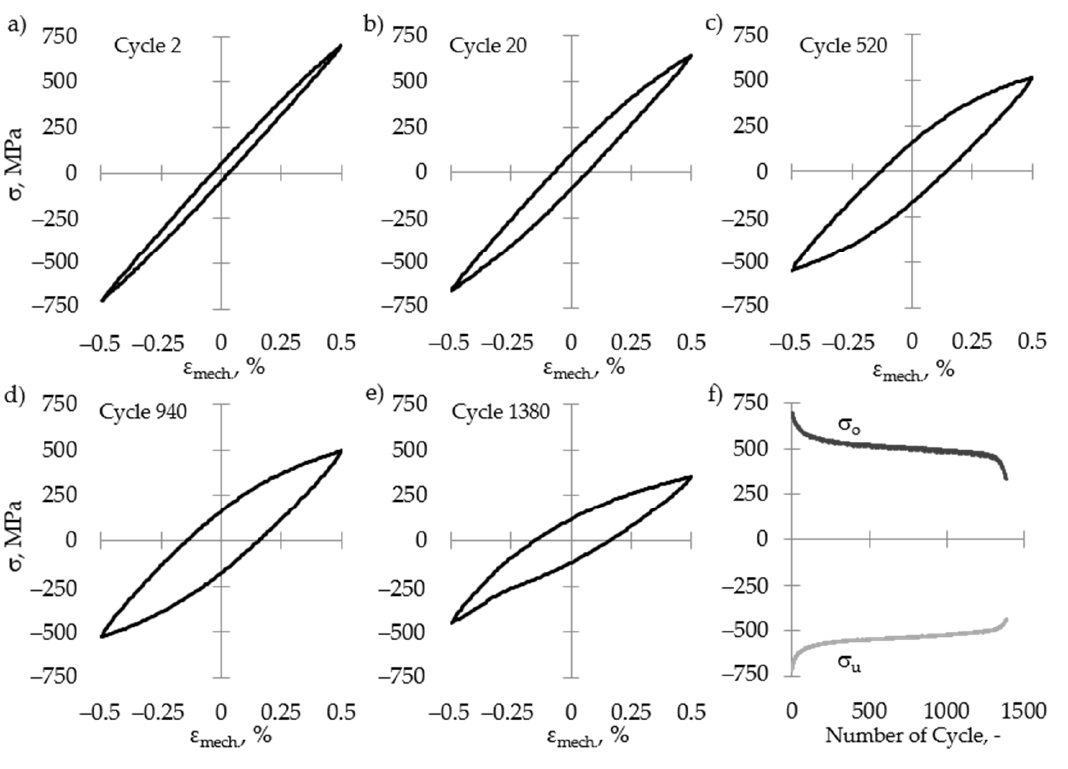
Figure 5. Stress−strain hysteresis loops after ( a ) 2 cycles, ( b ) 20 cycles, ( c ) 520 cycles, ( d ) 940 cycles, ( e ) 1380 cycles, and ( f ) maximum and minimum stress vs number of cycles for the fatigue test cor- responding to Figure 4 .